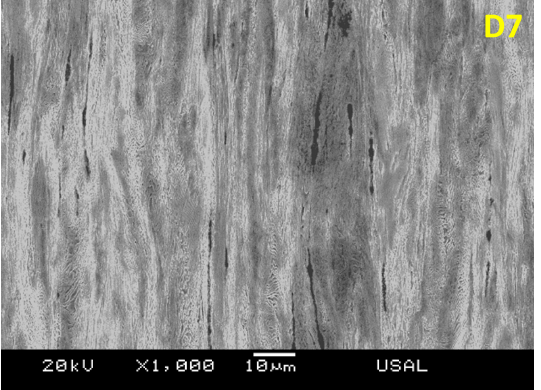
Figure 14. Multiple micro-cracks aligned in longitudinal direction (axial or cold-drawing direction, i.e., vertical side of the micrograph) in a cold drawn pearlitic steel.